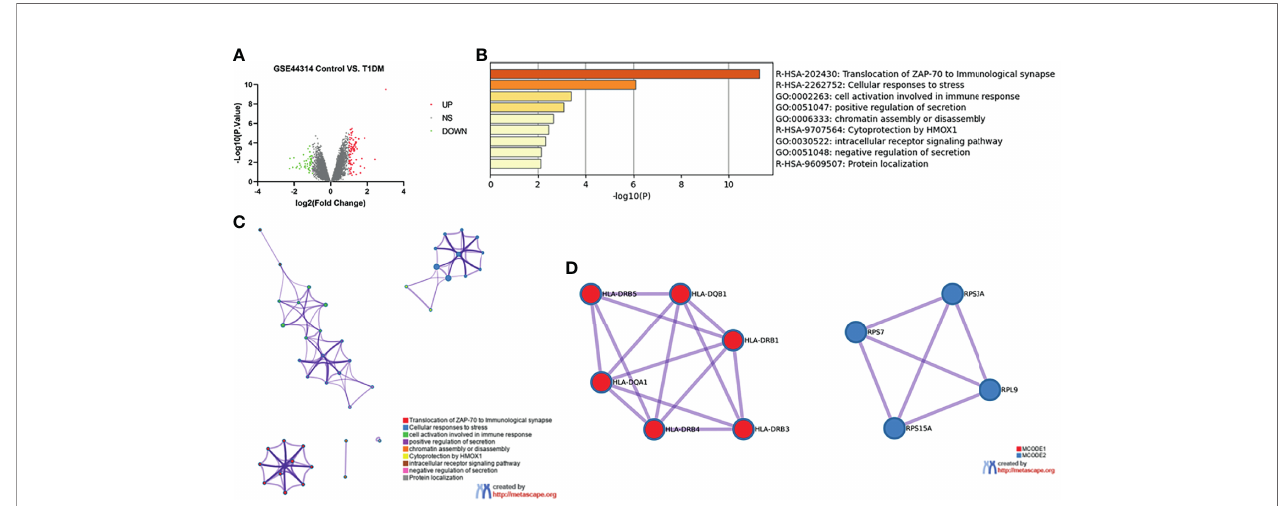
FIGURE 1 | Differentially expressed genes in T1DM ketosis or ketoacidosis. (A) Volcano plot for differentially expressing genes between T1DM recovered from ketosis or ketoacidosis and healthy control samples. Red dots represented upregulated genes, while green dots represented downregulated genes. (B) Heatmap of Gene Ontology (GO) and Kyoto Encyclopedia of Genes and Genomes (KEGG) enriched clusters colored by p -value. (C) Network of GO and KEGG enriched terms colored by clusters. (D) MCODE algorithm was applied to this network to identify neighborhoods. Each MCODE network was assigned a unique color. GO enrichment analysis was applied to each MCODE network to assign “ meanings ” to the network